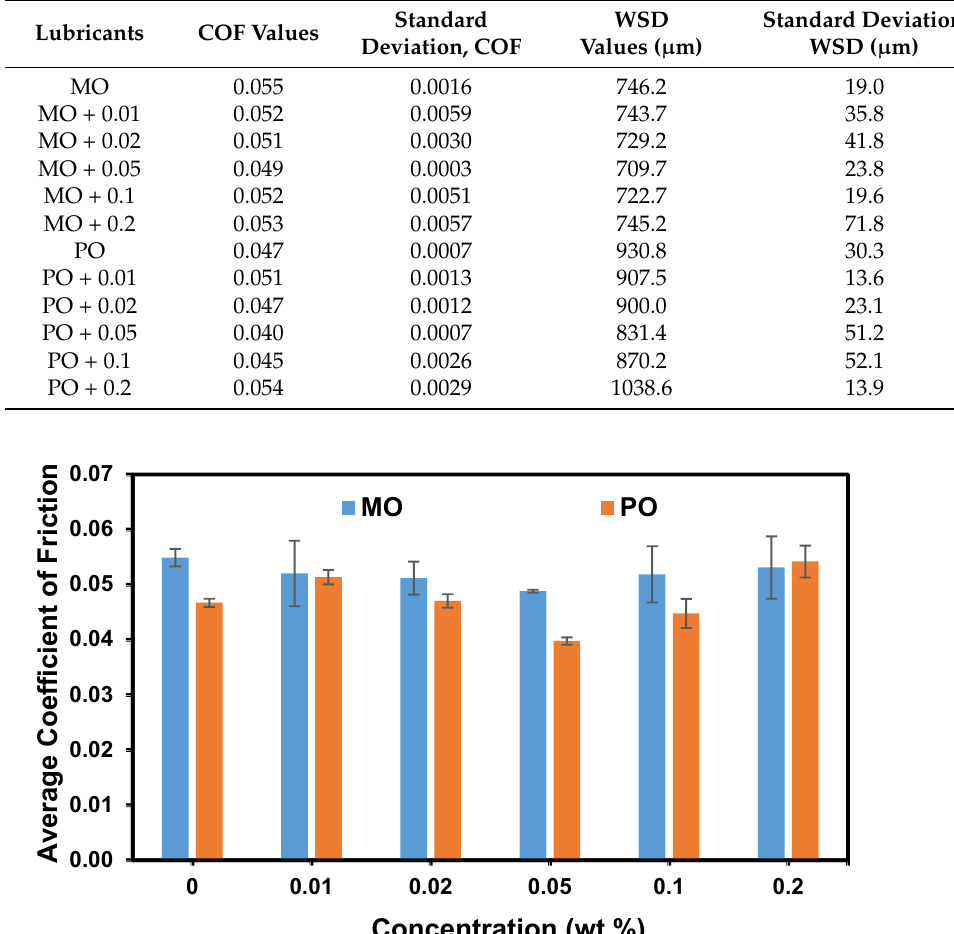
Figure 5. The WSD results achieved using both PO and MO oils with different GNPs concentrations (0 to 0.2 wt %).